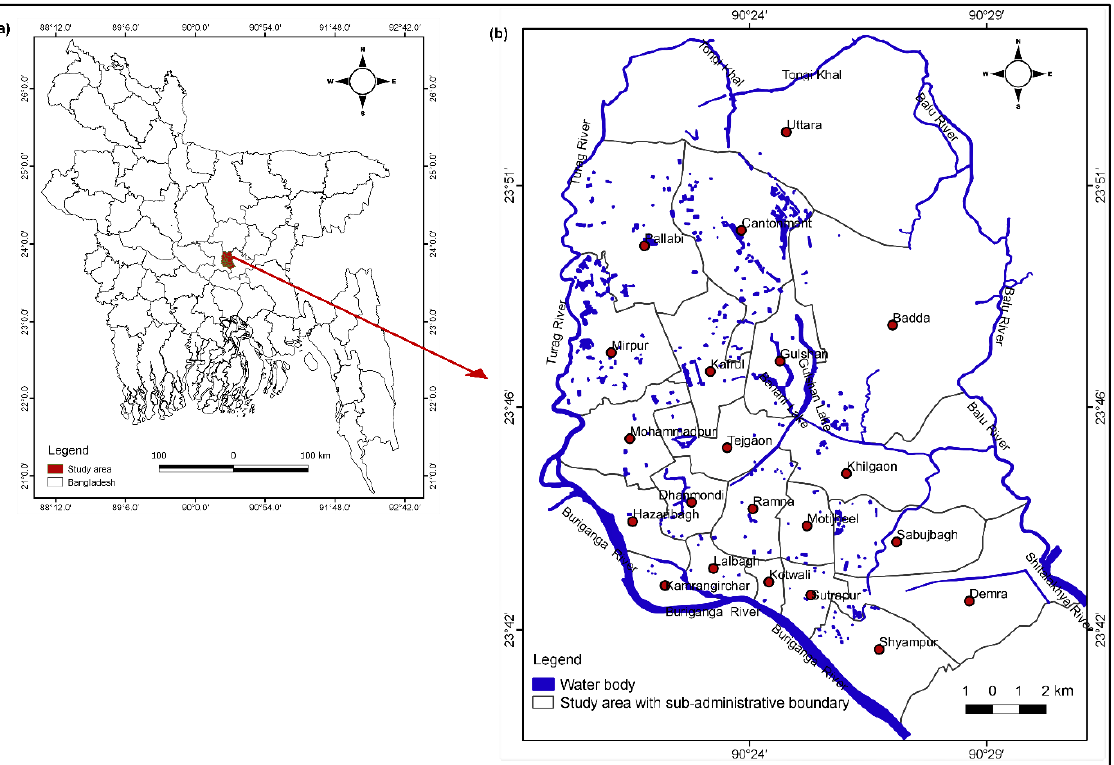
Figure 1. ( a ) Location of Dhaka city in the central part of Bangladesh. ( b ) Study area (Dhaka city) map with sub-administrative boundary.